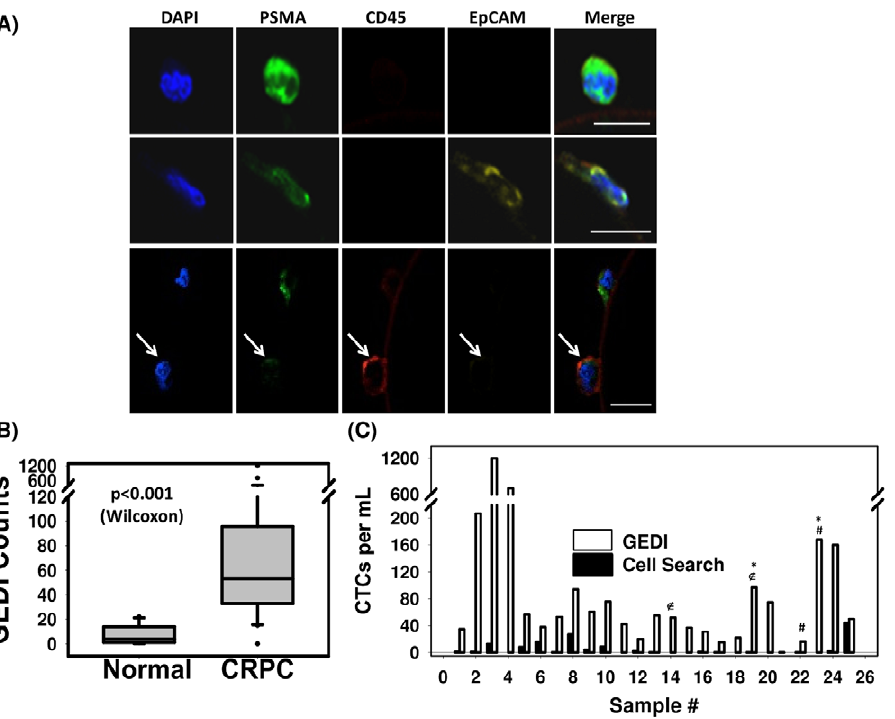
Figure 3. CTC enumeration using the GEDI and comparison to capture by Cell Search. (A) Representative images of circulating tumor cells captured with the GEDI device from 1 mL of blood from prostate cancer patients. CTCs are imaged on the device and are identified following immunostaining with DAPI, PSMA, CD45, and EpCAM. Intact, nucleated cells that are PSMA + /CD45 2 are identified as CTCs. Leucocytes are identified as DAPI + /PSMA 2 /CD45 + (bottom row, arrow). Note the heterogeneity of EpCAM expression in the PSMA + cell population (top and bottom rows, EpCAM-; middle row, EpCAM + ). Scale bar: 10 m m. (B) Disease-specific GEDI capture of CTCs. CTC enumeration (CTCs/ml) was performed using blood from healthy donors (median=3) and CRPC patients (median=54). (p , .001; Wilcoxon) (C) Comparison of CTC enumeration between GEDI-based- and CellSearch H -based capture. This comparison was performed using same-day blood draws from 25 individual CRPC patients. * indicates that CellSearch-based enumeration was performed 1 week before GEDI-based enumeration; 1 indicates same patient whose blood was drawn on two separate time points three months apart (blood draw no 14 occurred 3 months after blood draw no 19); # indicates same patient whose blood was drawn on two separate time points 1 year apart (blood draw no 22 occurred 1 year before blood draw no